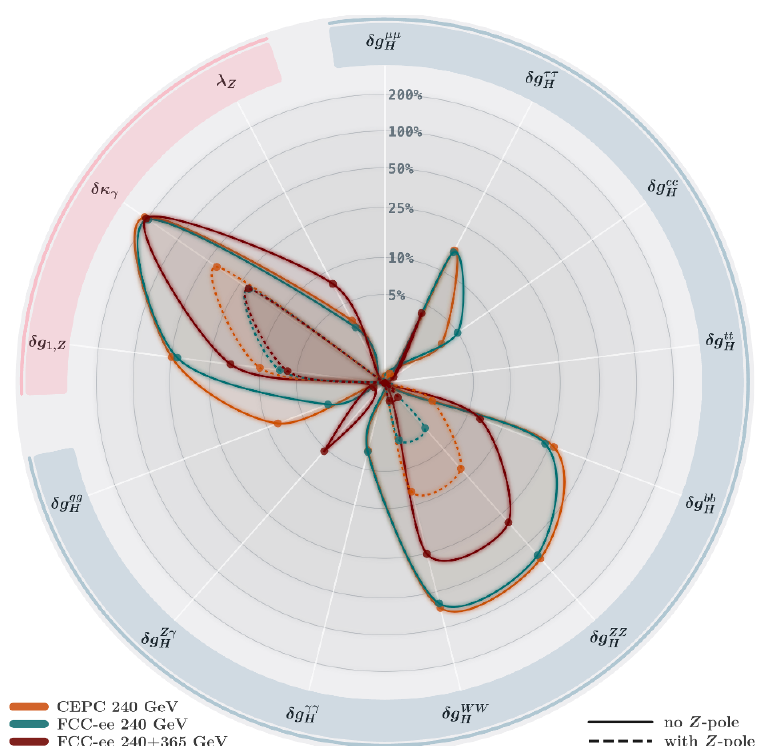
Figure 3 . Degradation in Higgs and triple-gauge coupling determinations due to EW uncertain- ties at future circular colliders. It is obtained by comparison with a perfect EW measurement scenario and quanti(cid:12)ed as (cid:14)g=(cid:14)g (EW ! 0) (cid:0) 1 expressed in percent. The dashed and solid lines are respectively obtained with and without new Z -pole run. Numerical values are also provided in